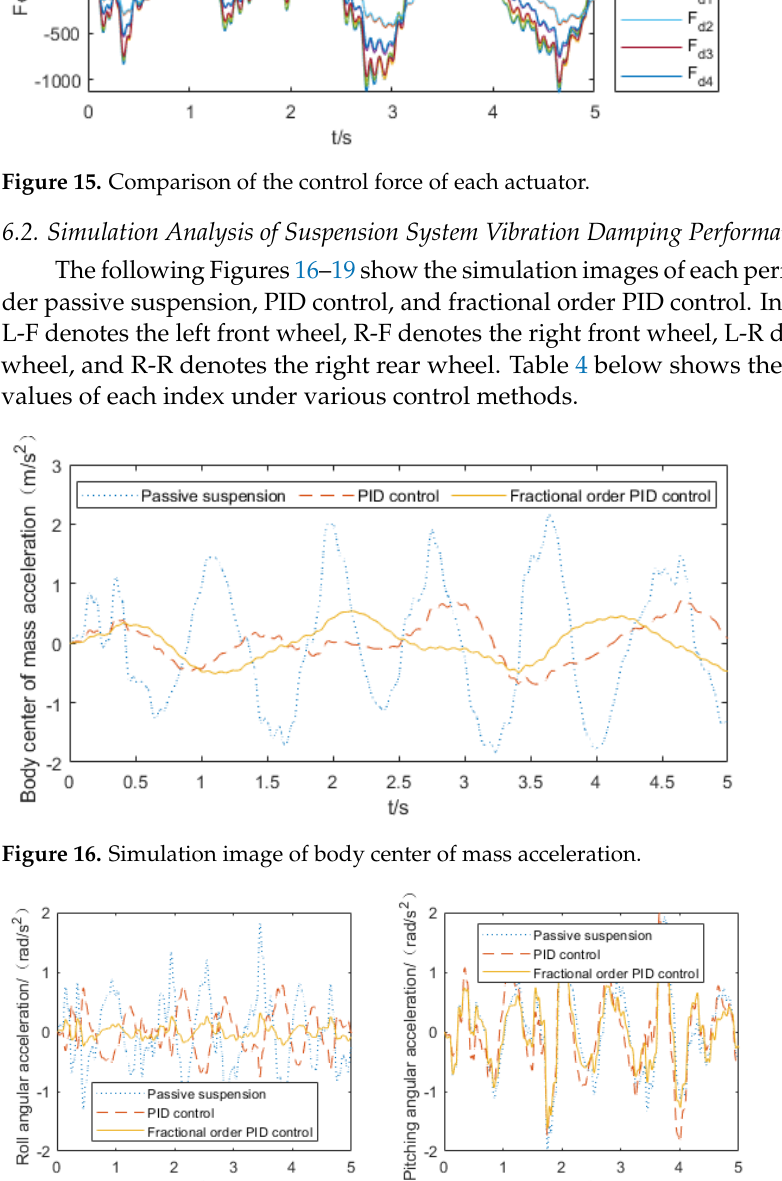
Table 4. Table of root mean square values of performance index.